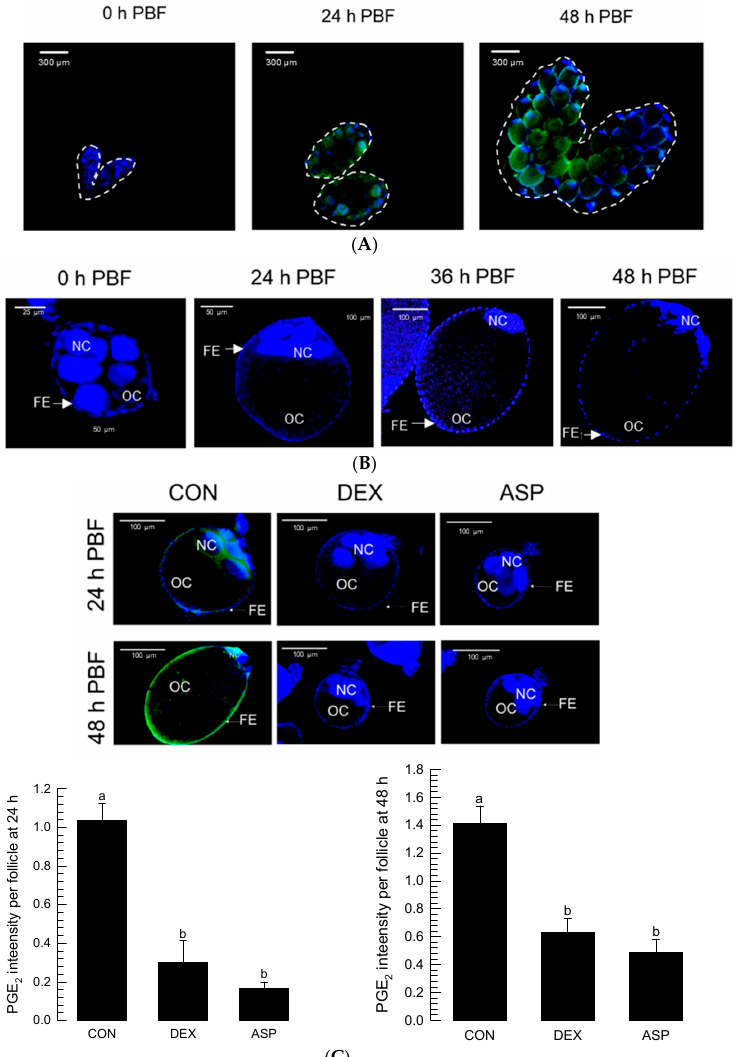
Figure 3. Detection of PGE 2 signals in the growing follicles of Ae. albopictus . ( A ) Oogenesis after blood-feeding (‘PBF’), along with PGE 2 signals (green colored) in the ovary. ( B ) Nurse cell dumping during oogenesis. ‘OC’, ‘FE’, and ‘NC’ stand for oocyte, follicular epithelium, and nurse cell, respec- tively. ( C ) Inhibitory effects of eicosanoid biosynthesis inhibitors on the induction of PGE 2 signal and subsequent prevention of nurse cell dumping. Dexamethasone (‘DEX’) or aspirin (‘ASP’) was injected at a dose of 100 ng/individual. Dimethylsulfoxide (‘DMSO’, 10%) used to dissolve inhibitors was injected as a control (‘CON’). PGE 2 fluorescence intensity levels were quantitatively measured at the oocytes ( n = 20) after inhibitor treatments using ImageJ software (https://imagej.nih.gov/ij (ac- cessed on 12 December 2022)). Different letters above standard error bars indicate significant differ- ences among means at Type I error = 0.05 (LSD test).